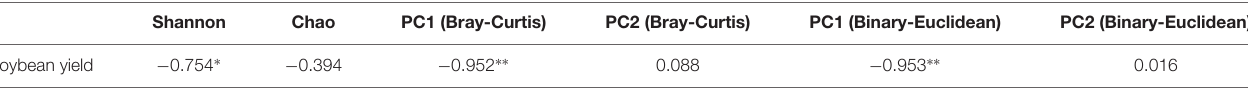
FIGURE 5 | Taxonomic cladogram produced from the LEfSe analysis. The phylum, class, order, family, and genus levels are listed in order from inside to outside of the cladogram, and the labels for levels of the family and genus are abbreviated using a single letter. Red, green, and blue showed taxa enriched in CS, RS, and SS, respectively, while the yellow circles represented the taxa without significant differences among the three cropping systems. RS, SS, and CS represented soybean rotation with a 3-year cycle of wheat, maize and soybean, short-term continuous soybean cropping with 1-year wheat and 2-year soybean, and long-term continuous soybean cropping, respectively. TABLE 1 | Pearson correlation coefficients between fungal community diversity and soybean yield. Shannon Chao PC1 (Bray-Curtis) PC2